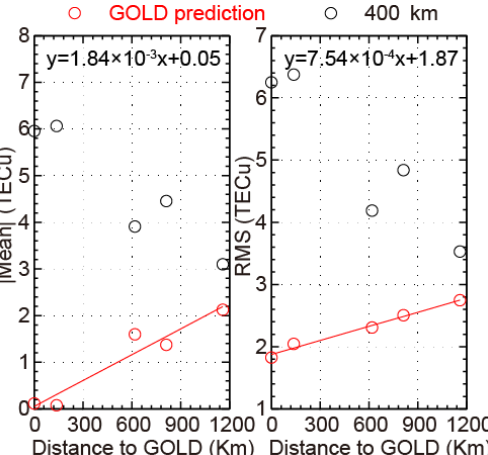
Figure 6. Relation of the accuracy for DCB estimation with the distance to GOLD. The red lines are the linear fitting results.